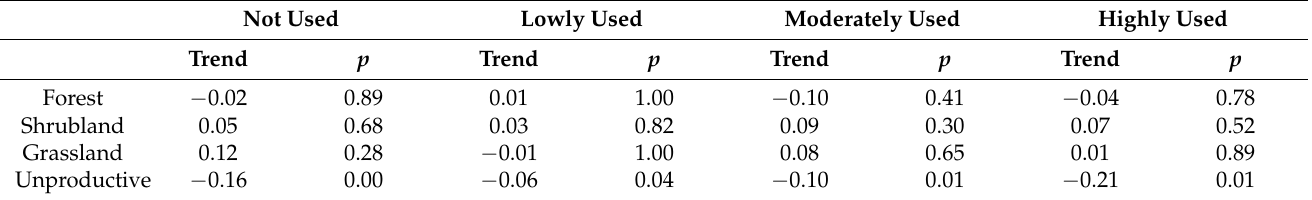
Table A1. Results of the trend analysis of the different types of land cover in the merino passes, differentiating degrees of utilization by sheep (not used, lowly used, moderately used, and highly used). The change column indicates the slope calculated with the Theil-Sen method (annual change for the variable of interest). p indicates the degree of significance according to the Mann-Kendall test. Not Used Lowly Used Moderately Used Highly Used Trend p Trend p Trend p Trend p Forest − 0.02